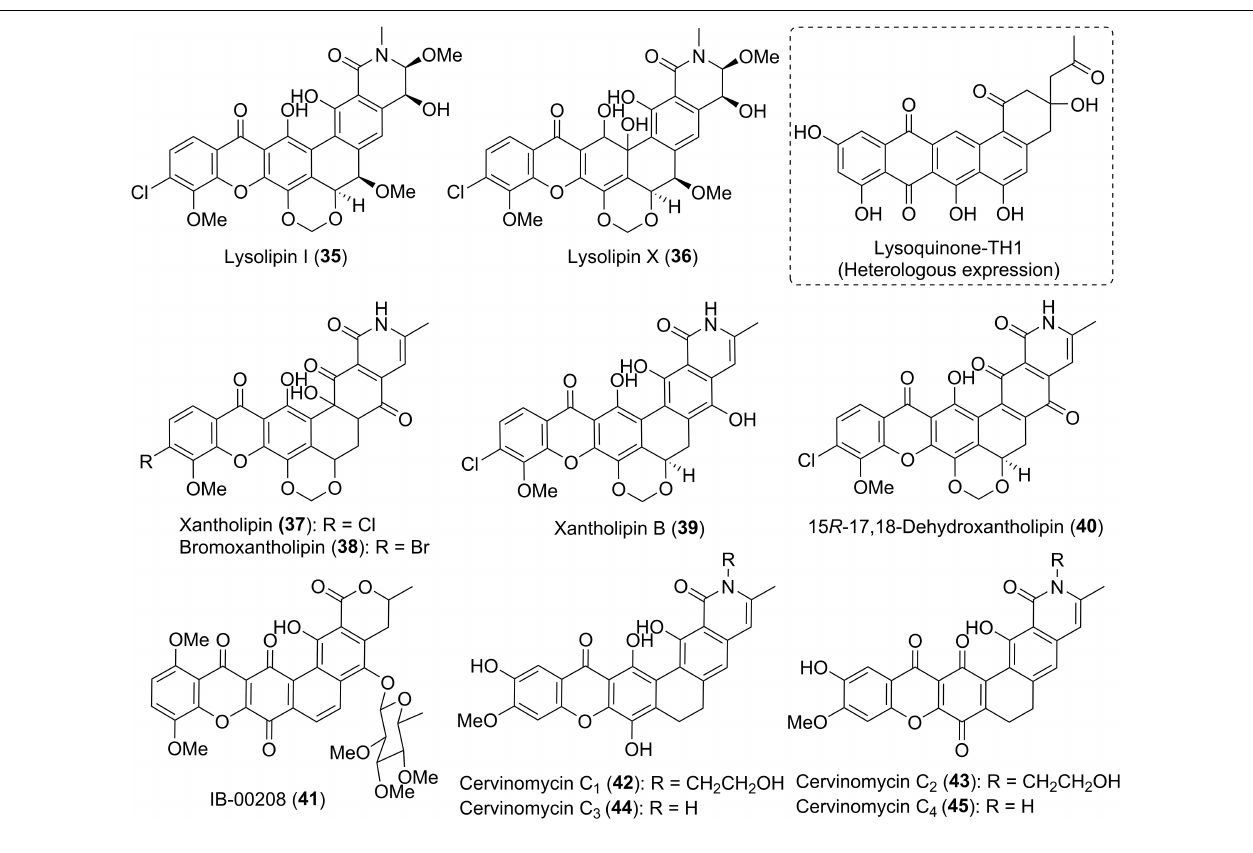
FIGURE 4 | Chemical structures of compounds 35–45